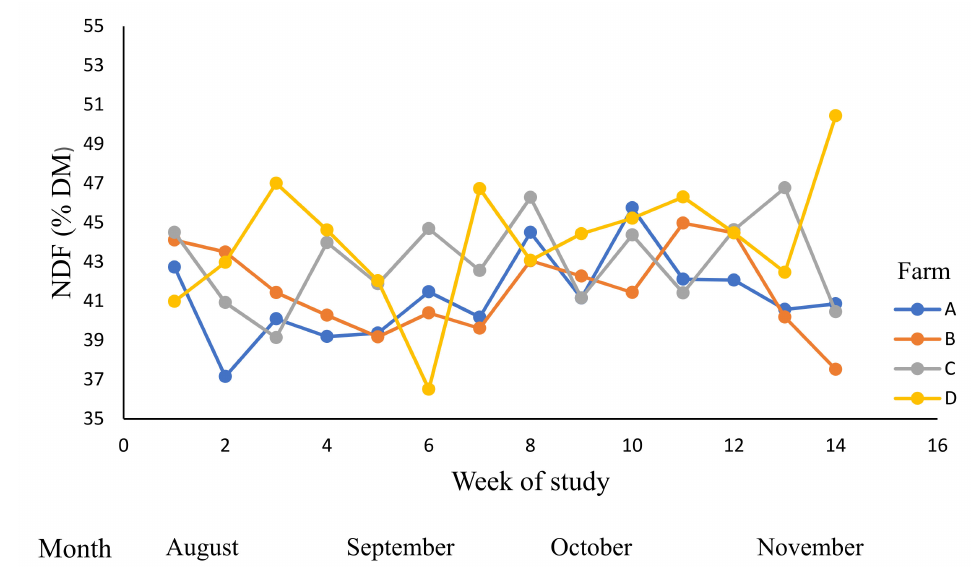
Figure 3. The variations in the neutral detergent fibre (NDF) contents (% dry matter (DM)) across dairy farms (A–D) during winter and spring; 0–14 weeks (August to November